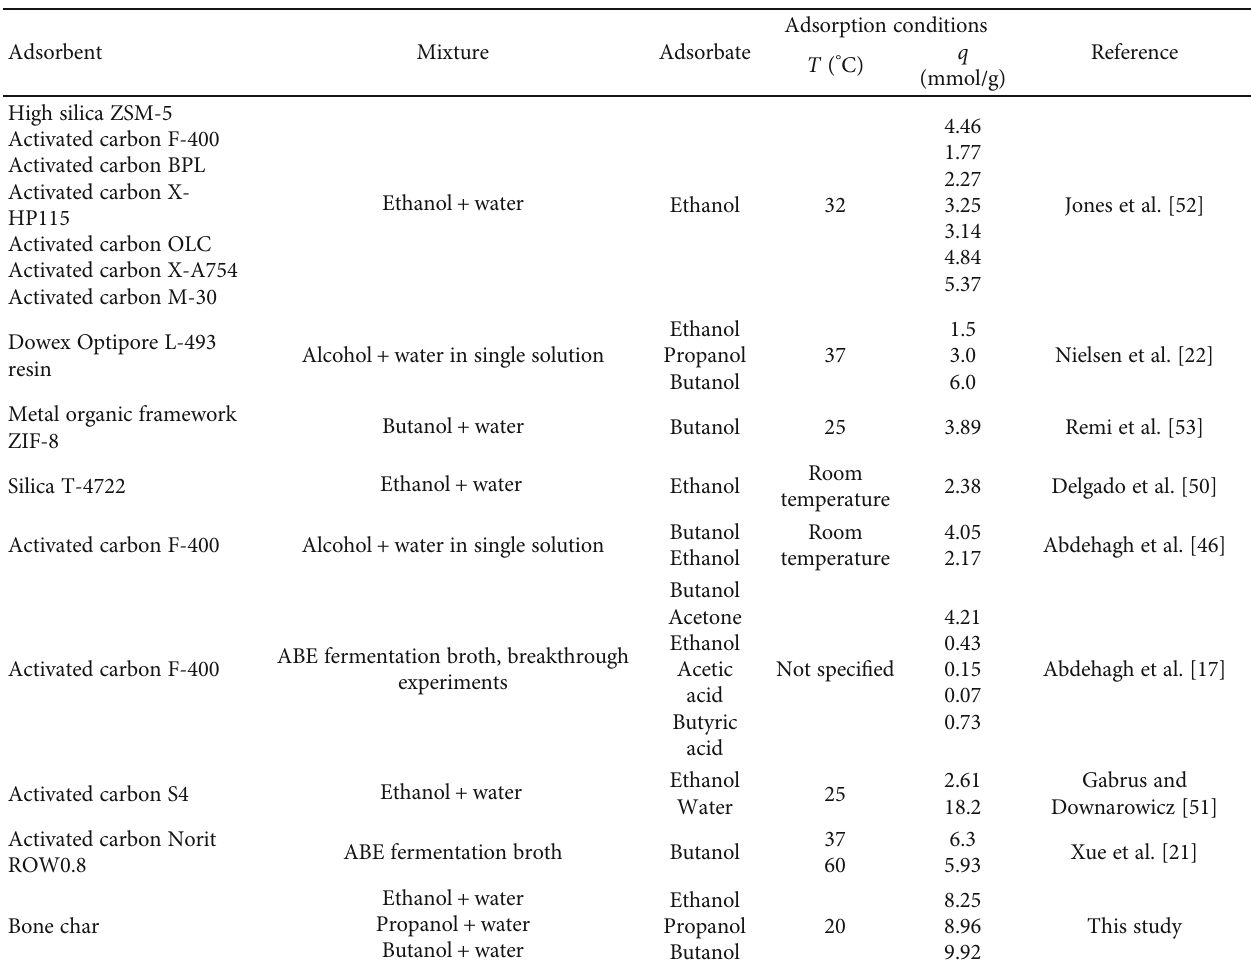
Table 6: Adsorption capacities of di ff erent adsorbents reported for the separation of